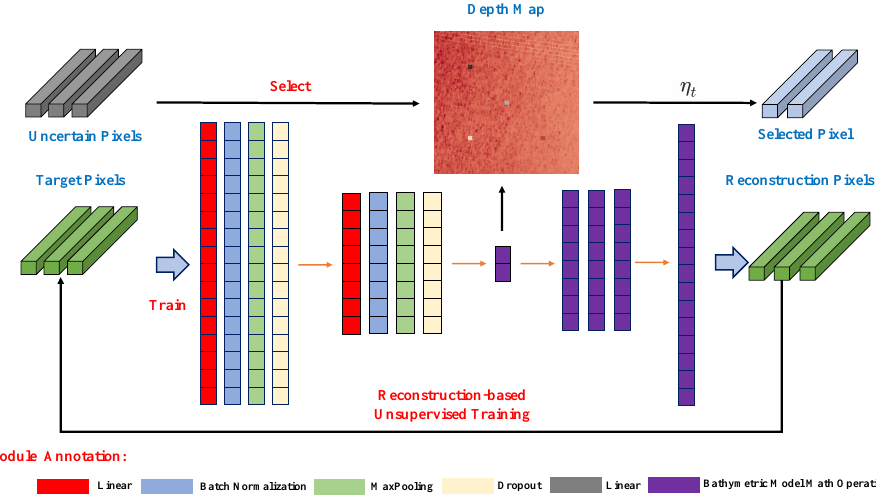
Figure 3. The overview of the autoencoder-form depth estimation